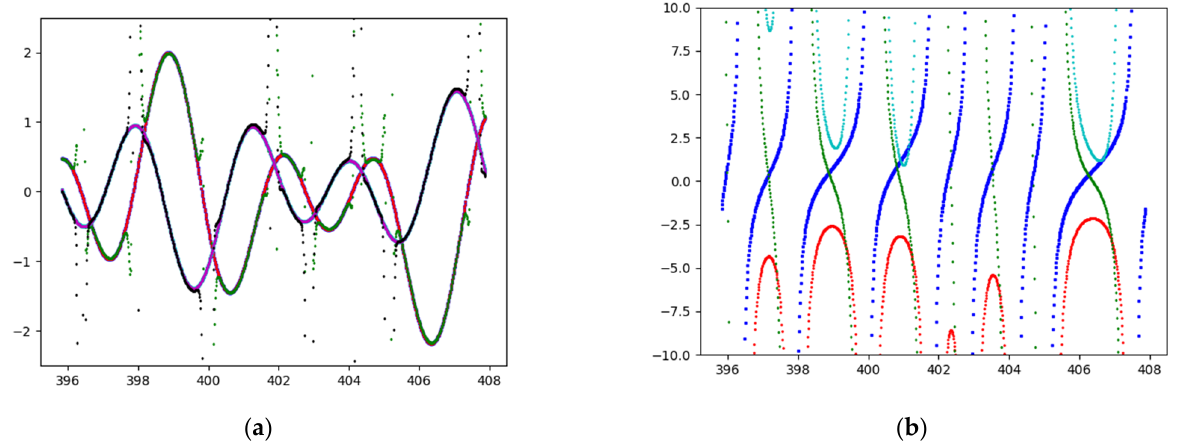
Table 4. General case not close to a zero: 𝐹 estimation in the CS from the CL (same 𝑦 ) via both methods with 𝐹 ((cid:3041)) and 𝑇 (cid:3041) . This table shows the good accuracy of the 𝐹 estimation with eight terms using the indirect way, with various 𝑦:100, 10 (cid:2871) , 10 (cid:2872) .